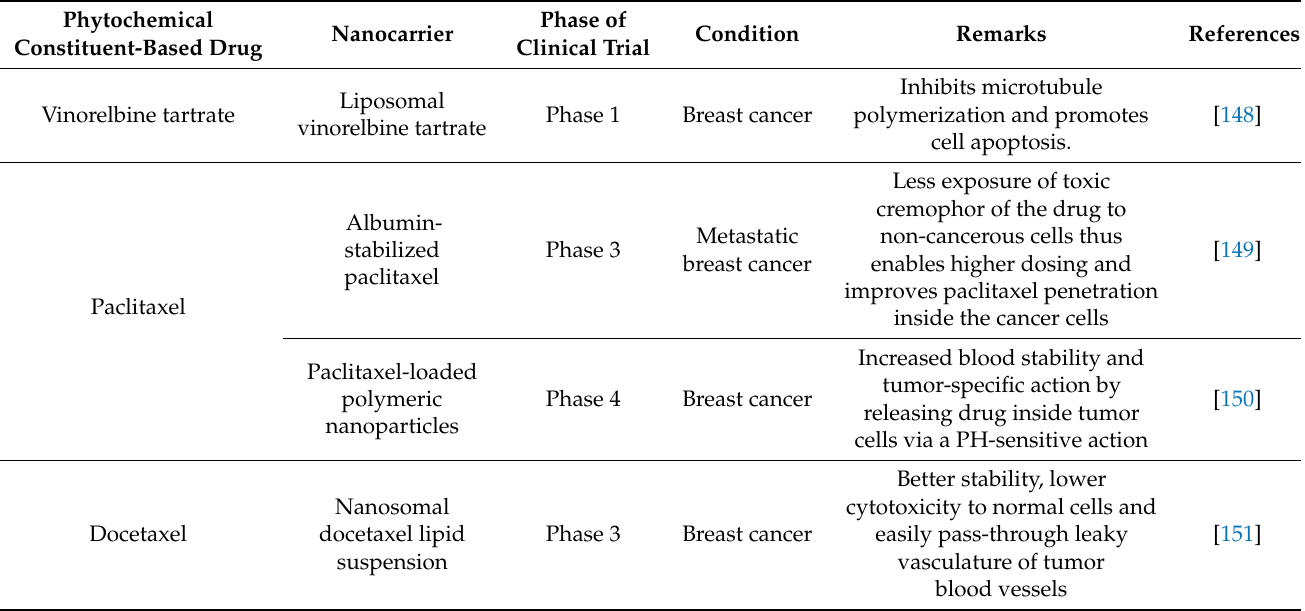
Table 4. Clinical studies utilizing phytochemical nanocarriers for breast cancer